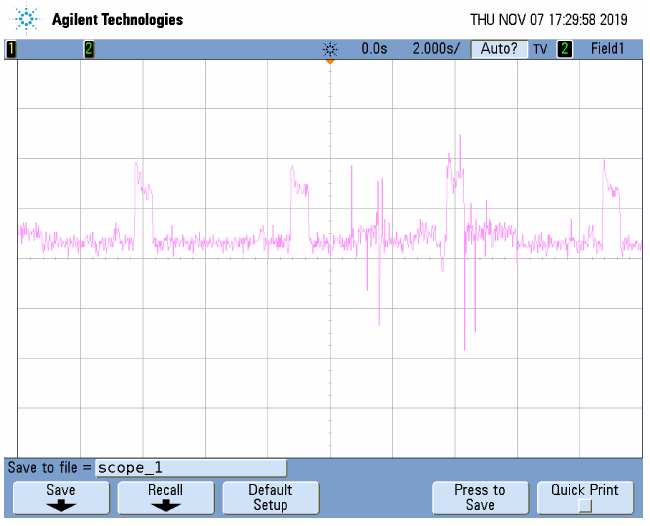
Figure 7. Power consumption measurements: voltage drop on an 0.56 Ω resistance (horizontal scale 50 mV, vertical scale 2